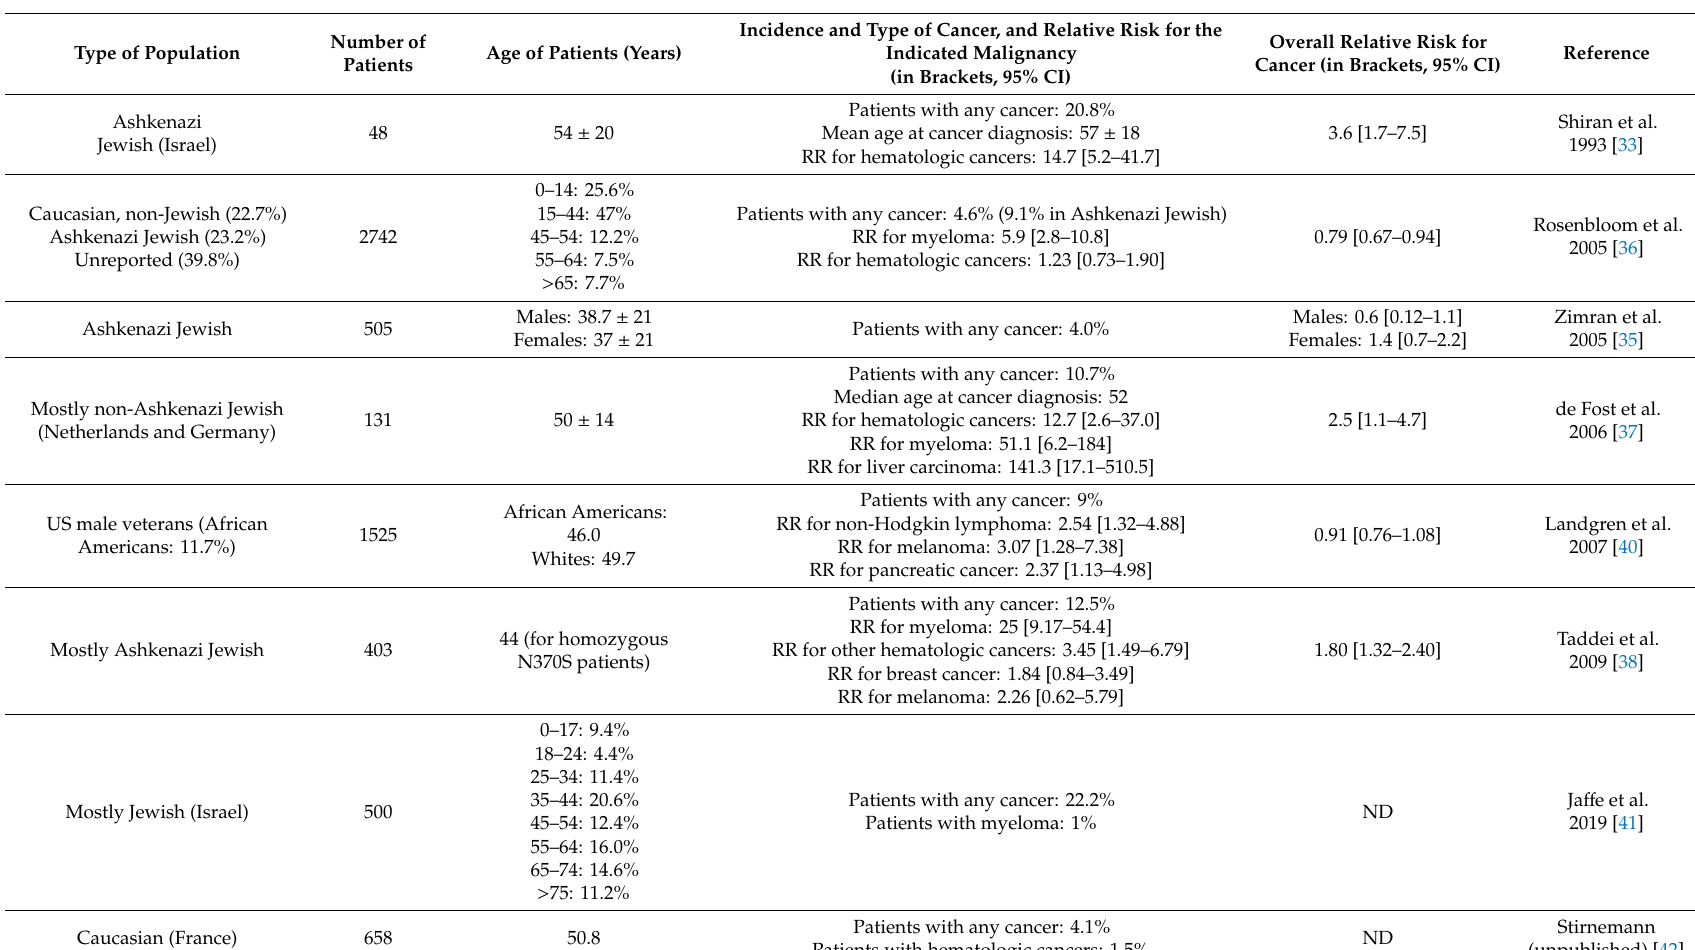
Table 1. Susceptibility of patients a ff ected with Gaucher disease to develop malignancies.